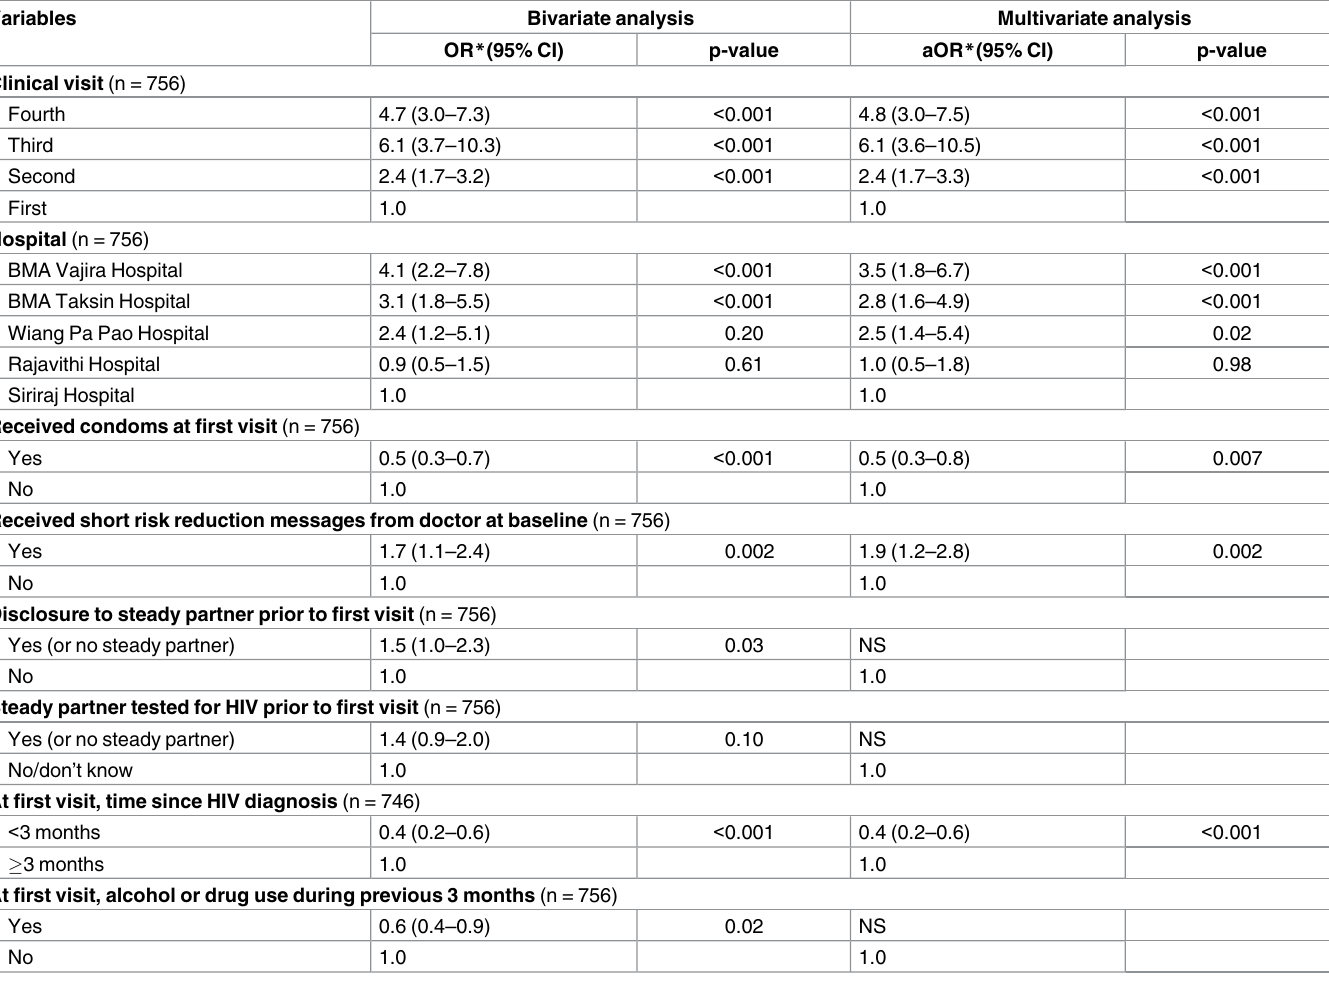
Table 4. Results of generalized estimating equation analysis of baseline factors associated with change from condomless sex to abstinence or 100% condom use at follow-up visits among PLHIV participating in prevention with positives intervention assessment, Thailand,